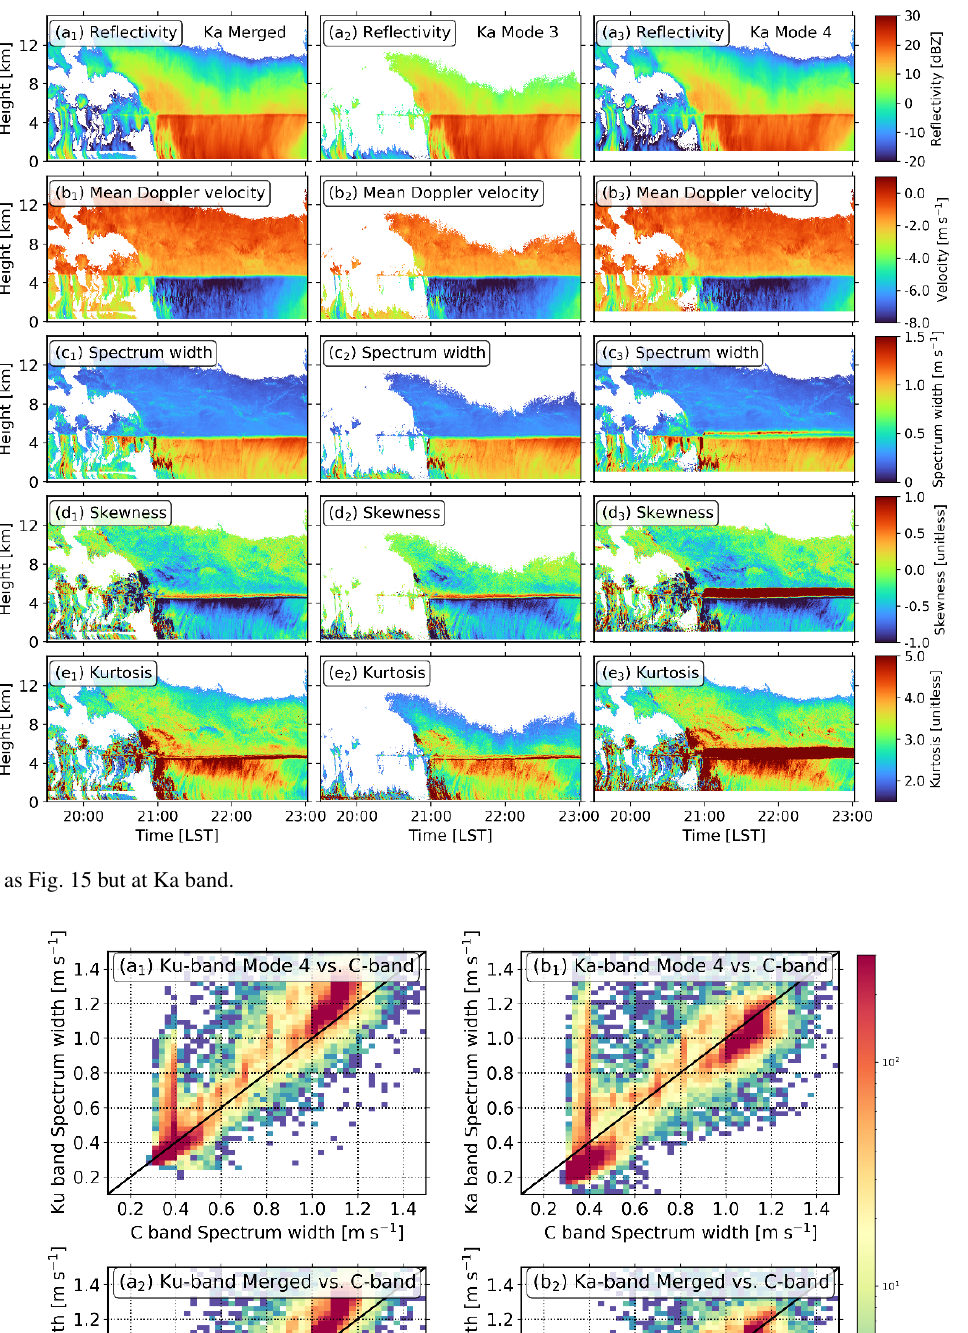
Figure 17. Spectrum width comparison between C band, (a1, a2) Ku band, and (b1, b2) Ka band. The spectrum width observations at mode 4 (a1, b1) and for merged data (a2, b2) were used for comparison. Radar observations from 1 to 9km during this event were employed.